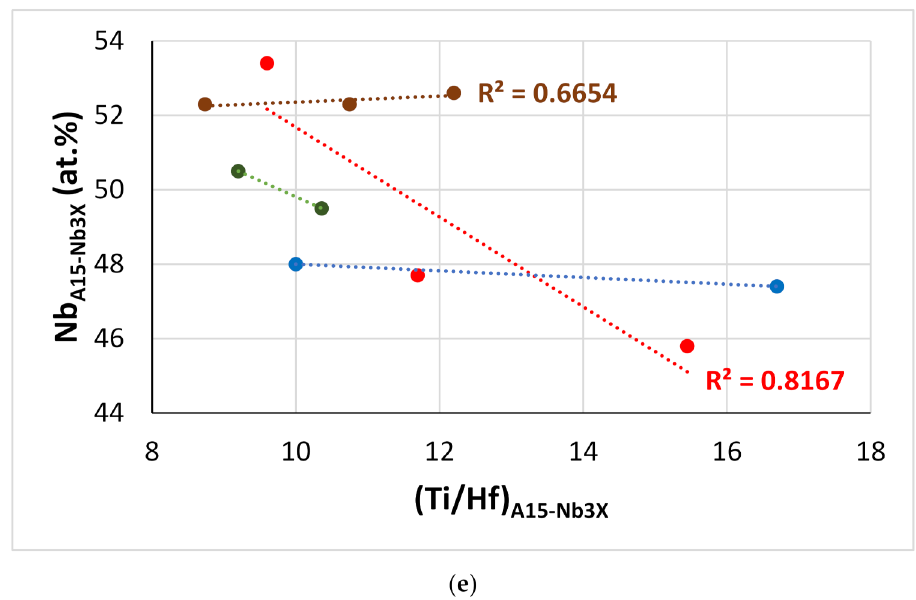
Figure 16. Trends in solute addition concentrations in A15-Nb 3 X in the alloys of this work: ( a ) Ti vs. Hf, ( b ) Hf vs. Sn, ( c ) Ti vs. Sn, ( d ) Ti vs. Si+Sn, and ( e ) Nb vs. Ti/Hf. Colors are as follows: EZ2 green, EZ5 brown, EZ6 red, EZ8 blue.